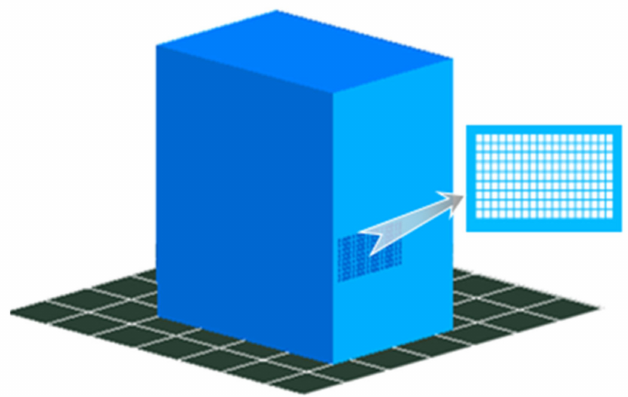
Figure 1. Sound insulation hood